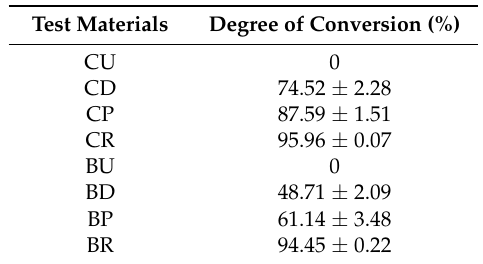
Table 3. Results of the degree of